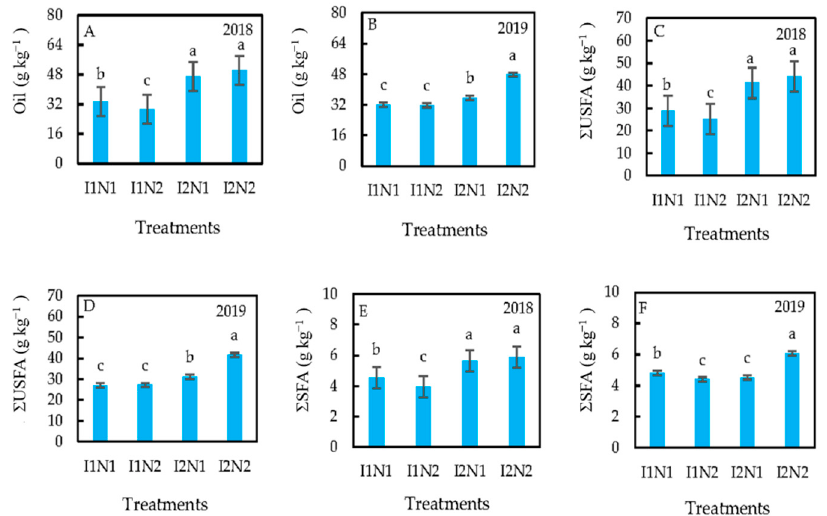
Figure 6. Least square means of maize grain oil ( A , B ), total unsaturated fatty acids ( Σ USFA) ( C , D ) and total saturated fatty acids ( Σ SFA) ( E , F ) in response to interaction effects of irrigation and nitrogen. I1, irrigation at 12-day intervals; I2, irrigation at 6 day-intervals; PD1, planting date 21 June; PD2, planting date 22 July; C1, KSC704; C2, KSC260; N1, 0; N2, 184 kg N ha − 1 . Least square means labelled with the same letter do not differ significantly at p < 0.05 based on Tukey’s test. Vertical bars represent the 95% confidence interval.